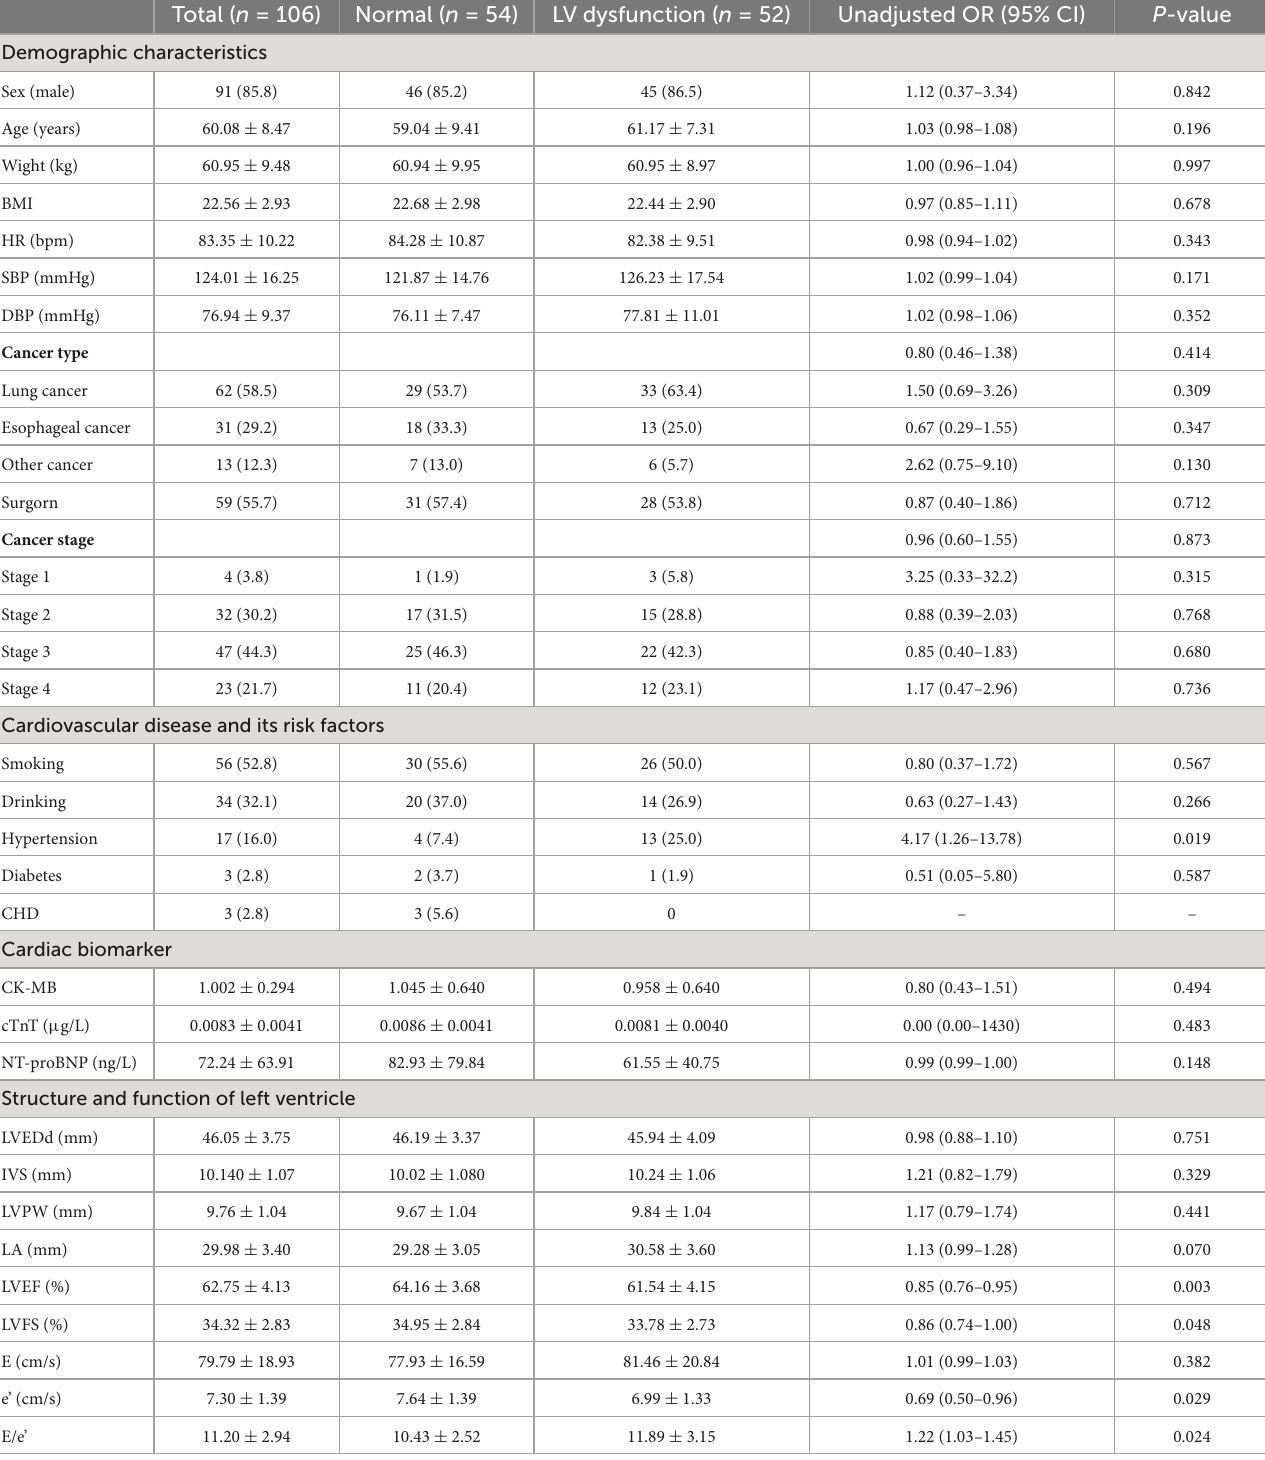
TABLE 1 Baseline characteristics of patients and univariate regression analysis between studied parameters and left ventricle (LV) dysfunction. Total ( n = 106) Normal ( n = 54) LV dysfunction ( n = 52) Unadjusted OR (95% CI) P